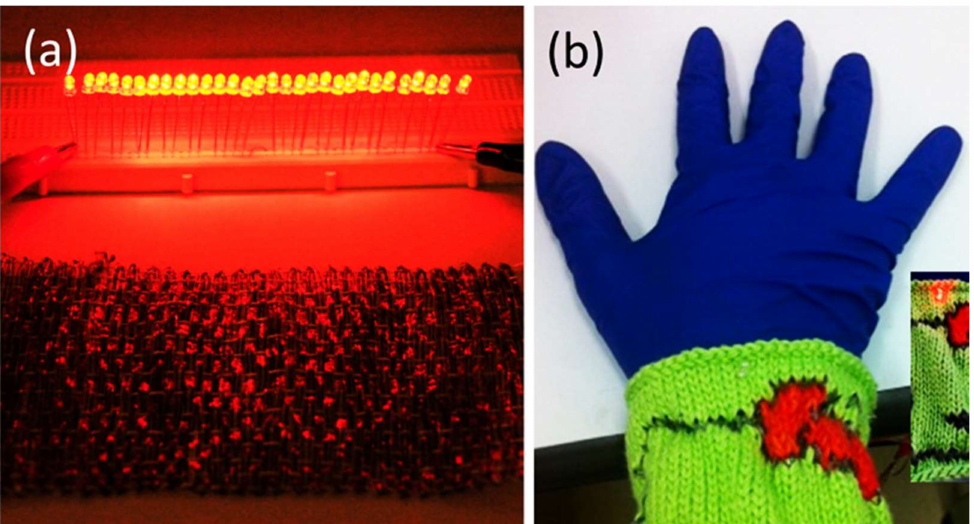
Figure 5. Digital image of an energy storage e-textiles made of conductive yarns. ( a ) The woven clothes (15 × 10 cm 2 ) can light 30 LEDs, and ( b ) a wrist band knitted with a pattern. The inset displays the pattern powering an LED. Reprinted with permission from [84]. Copyright (2015) American Chemical